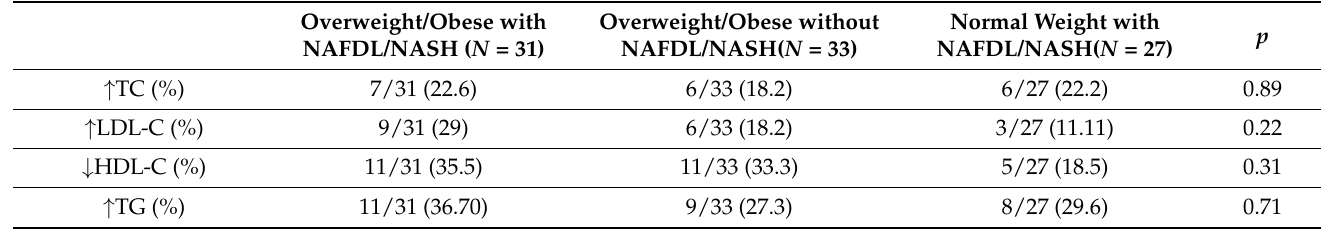
Table 2. Abnormal lipid profile by group of participants (group 1: overweight/obese with NAFLD or NASH; group 2: overweight/obese without NAFLD/NASH; and group 3: normal-weight children with NAFLD/NASH).